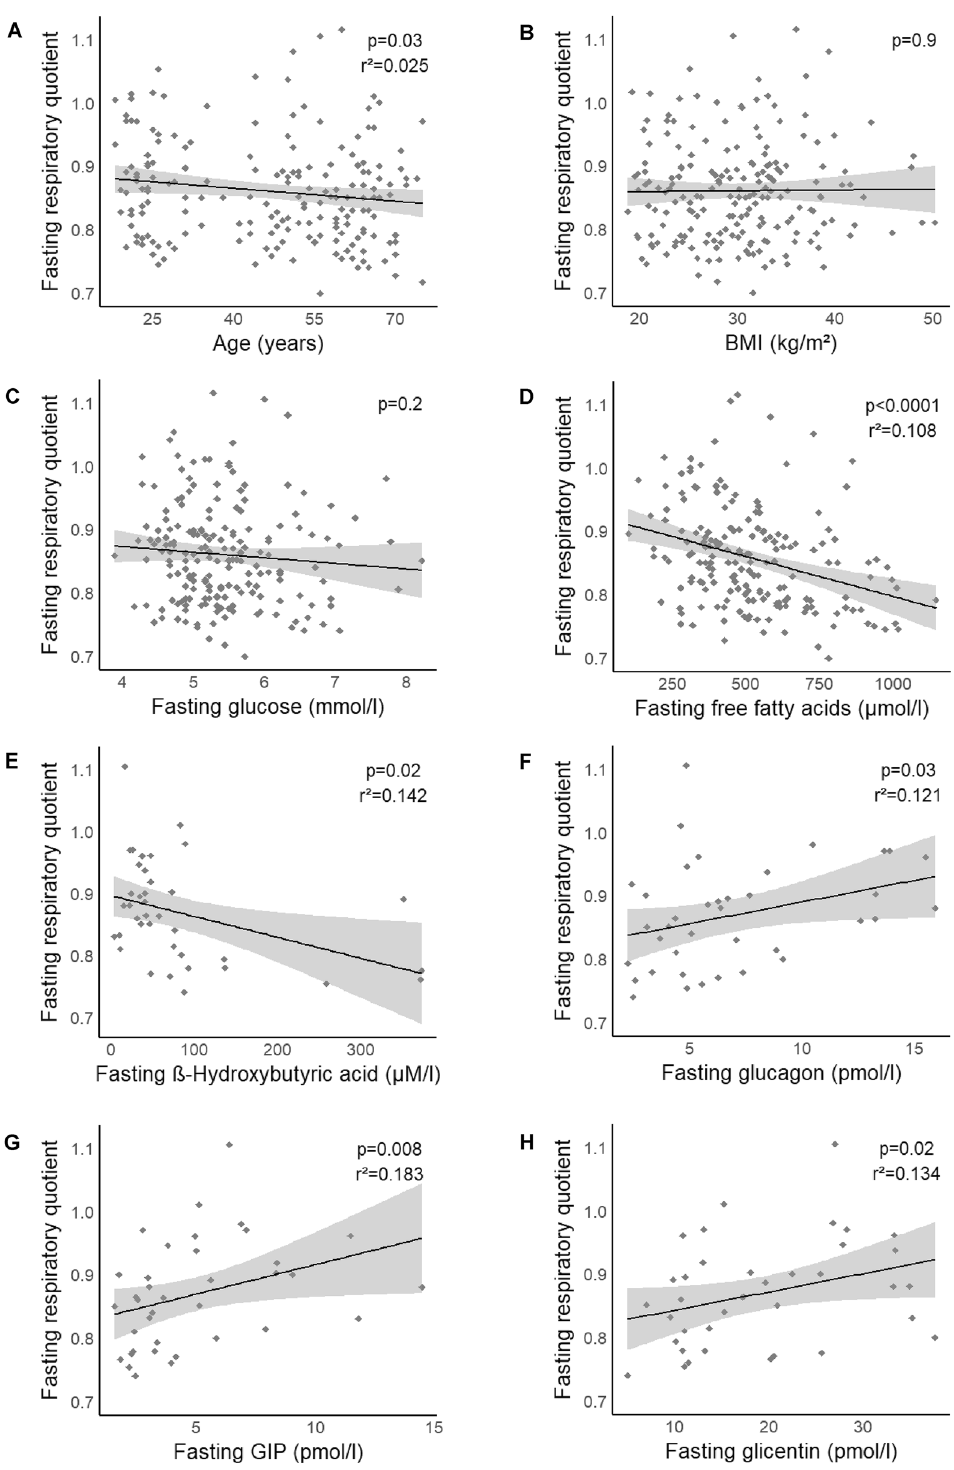
Figure 1. Association of respiratory quotient (RQ) and its´potential determinants . RQ was negatively associated with age ( A ), with lower RQ values with increasing age. No correlation between RQ and BMI ( B ) or plasma glucose ( C ) was detected. Free fatty acids ( D ) as well as the ketone body ß-hydroxybutyric acid ( E ) were significantly correlated to RQ. Glucagon ( F ), GIP ( G ) and glicentin ( H ) were positively associated to RQ. Data are presented as scatterplots with linear regression lines and 95% CI. p values were taken from linear regression